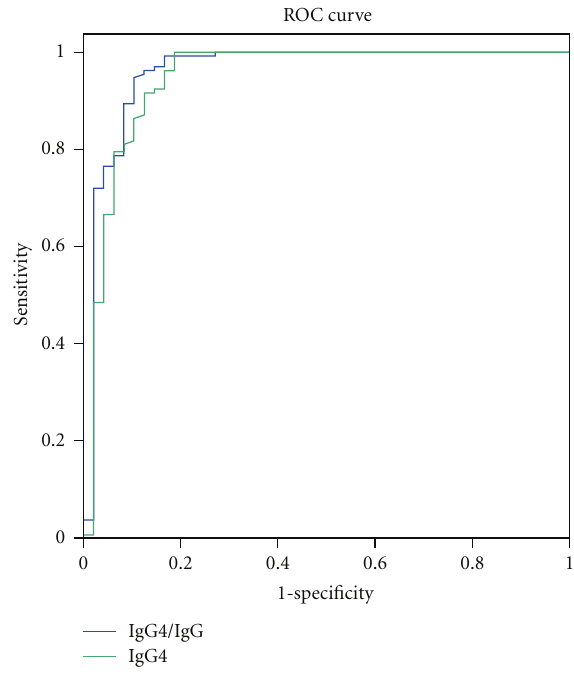
Figure 1: ROC curves of absolute serum IgG4 concentration (green) and serum IgG4/IgG ratio (blue). The two curves were almost identical.